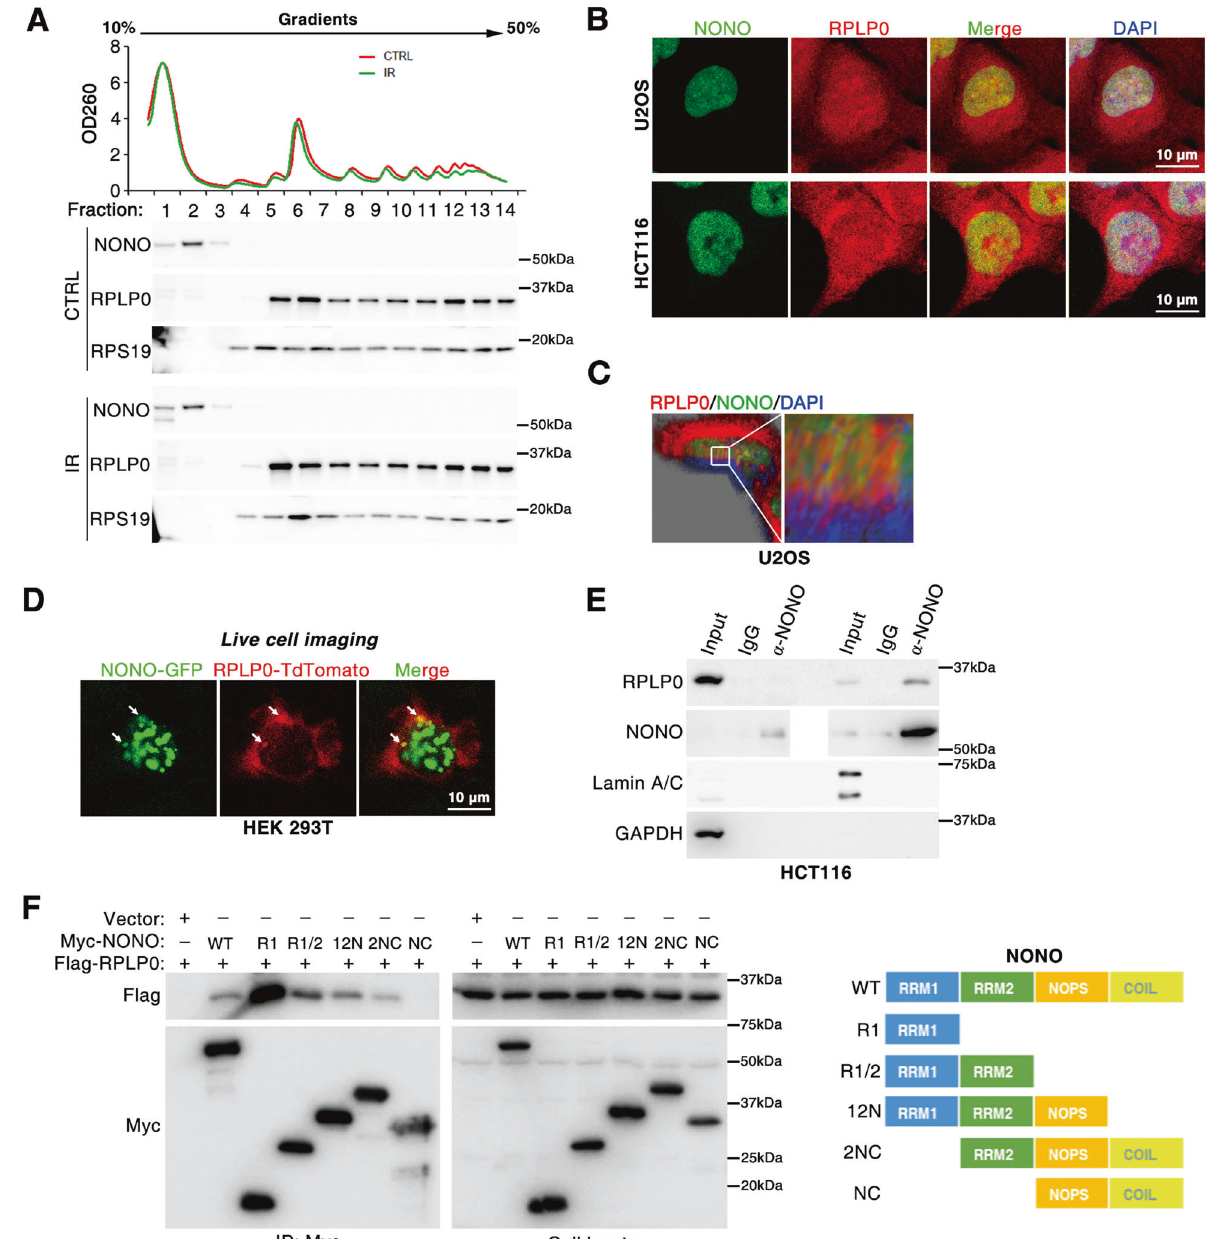
Fig. 2 Nuclear RPLP0 interacts with the RRM1/2 domain of NONO. A NONO was not detected in ribosome. Ribosomal protein of HCT116 cells with or without IR was fractionated with sucrose density gradient ultracentrifugation. B The colocalization between NONO and RPLP0 was analyzed with immuno fl uorescence. C Z-stacking imaging con fi rmed the association between RPLP0 and NONO. D RPLP0-tdTomato and NONO-GFP colocalize in HEK 293T cells. Twenty-four hours after transfection with RPLP0-tdTomato and NONO-GFP plasmids, HEK 293T live cells were imaged using confocal microscopy. E RPLP0 and NONO interact in nucleus. Cytoplasmic and nuclear proteins were fractionated and subjected to CoIP assay with anti-NONO antibody. GAPDH and Lamin A/C served as negative controls that did not interact with NONO for cytoplasmic and nuclear extracts, respectively. F RRM1 and RRM2 domains of NONO associate with RPLP0. HEK 293T cells were transfected with different mutants of Myc-NONO and Flag-RPLP0 before CoIP protein levels of NONO and RPLP0 were analyzed in biopsy model showed that although NONO depletion had no impact on specimens from LARC patients receiving radiochemotherapy. the growth of MC38 (a mouse colon cancer cell line) xenografts in Compared with tumor tissues from patients sensitive to radio- the control group, NONO-KO MC38 cells-derived xenografts chemotherapy (TRG0, tumor regression grades 0), both NONO and remained smaller than that of wildtype cells in radiotherapy RPLP0 proteins were highly expressed in that from resistant group, indicating that depletion of NONO sensitized tumor cells to patients (TRG3) (Fig. 6D and Fig. S5). Additionally, data from tissues radiotherapy (Fig. 6C). post neoadjuvant therapy showed a similar result (Fig. 6E). We further evaluated the clinical signi fi cance of NONO and Furthermore, compared with normal adjacent tissues, both mRNA RPLP0 in patients with locally advanced rectal cancer (LARC). The